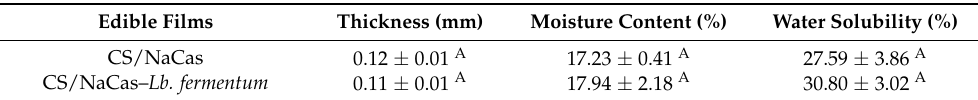
Table 4. Thickness, moisture content, and water solubility of composite edible films with or without Lb. fermentum .